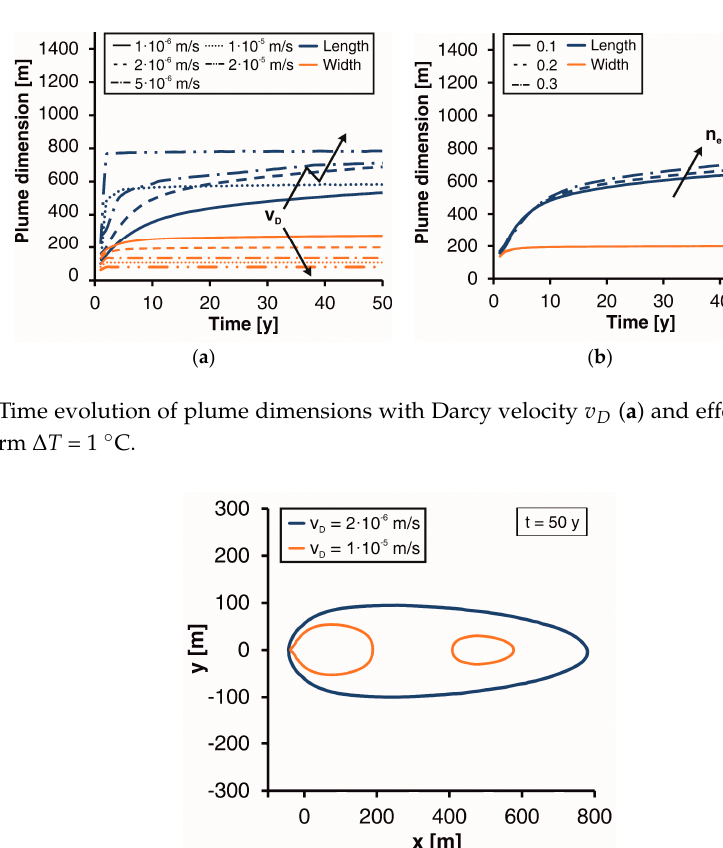
Figure 6. Thermal plume shape after a 50 years simulation, for different values of Darcy velocity v D ; isotherm ∆ T = 1 °C.